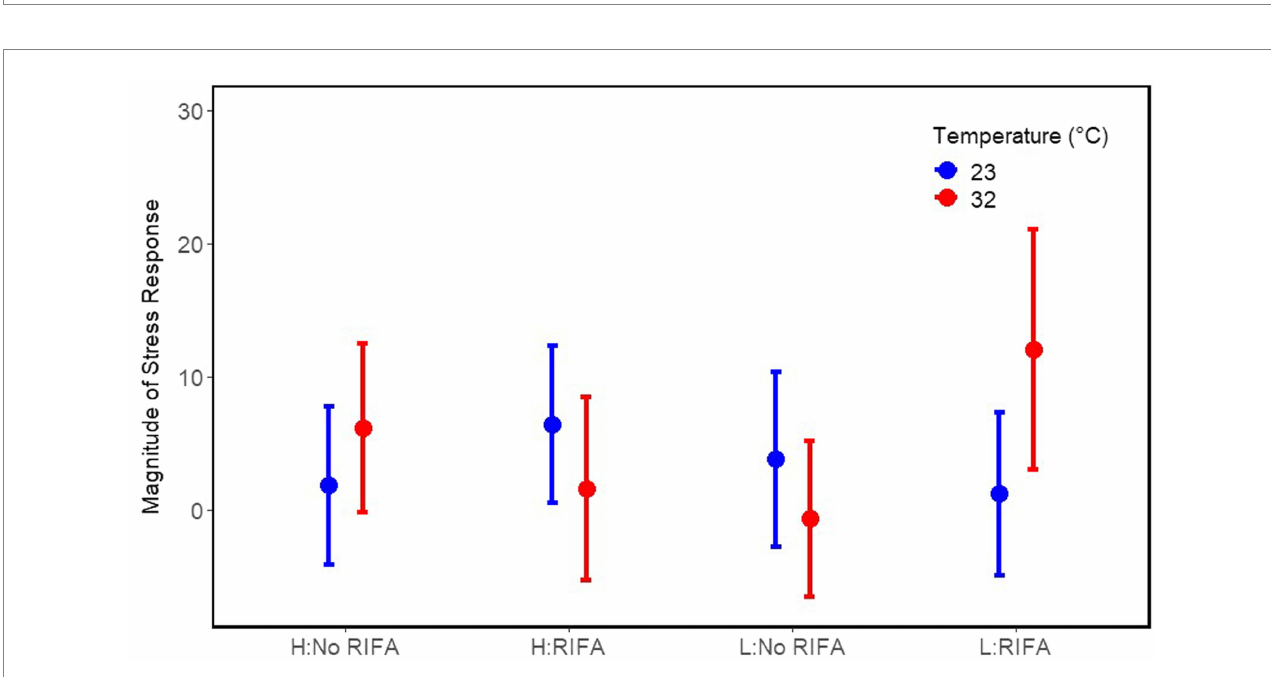
FIGURE 3 The estimated marginal means of the magnitude of the stress response of I. nebulifer toadlets by treatment. Error bars are 95% confidence intervals. “L” and “H” refer to low and high (adequate) water levels,